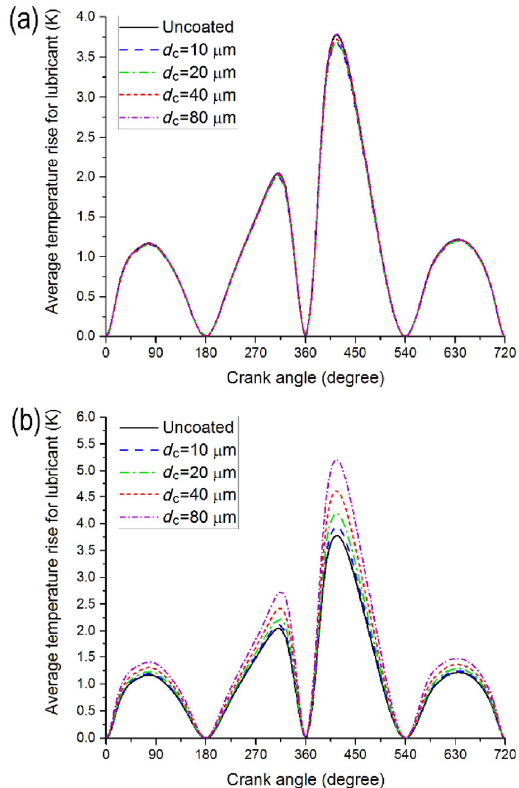
Fig. 10 The variations of average temperature rises for lubricant when different thicknesses of coatings are adopted: (a) for the high thermal inertia coating; (b) for the low thermal inertia coating.